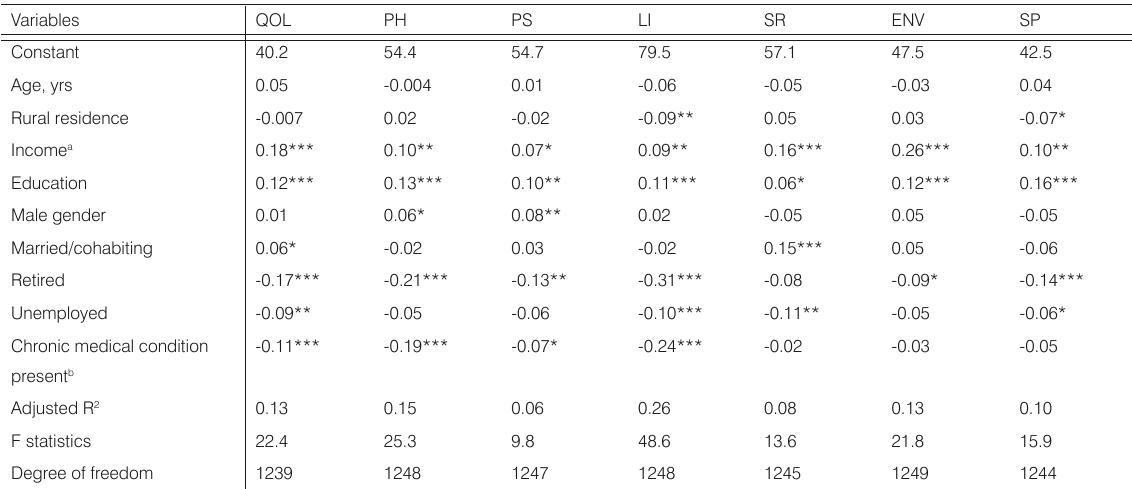
Table 3. Multiple linear regression models of the adjusted influence of country residence and socio-economic status on the WHO-QOL-100 scores among the Lithuanian